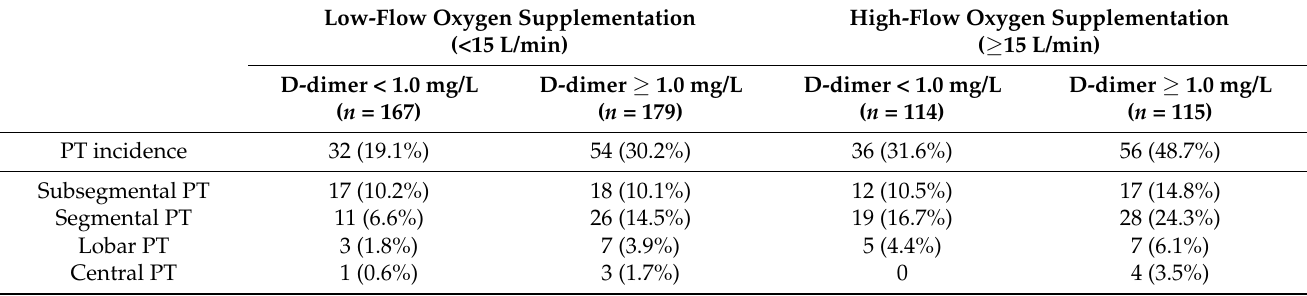
Table 4. Frequencies of PT stratified by oxygen support and D-dimer